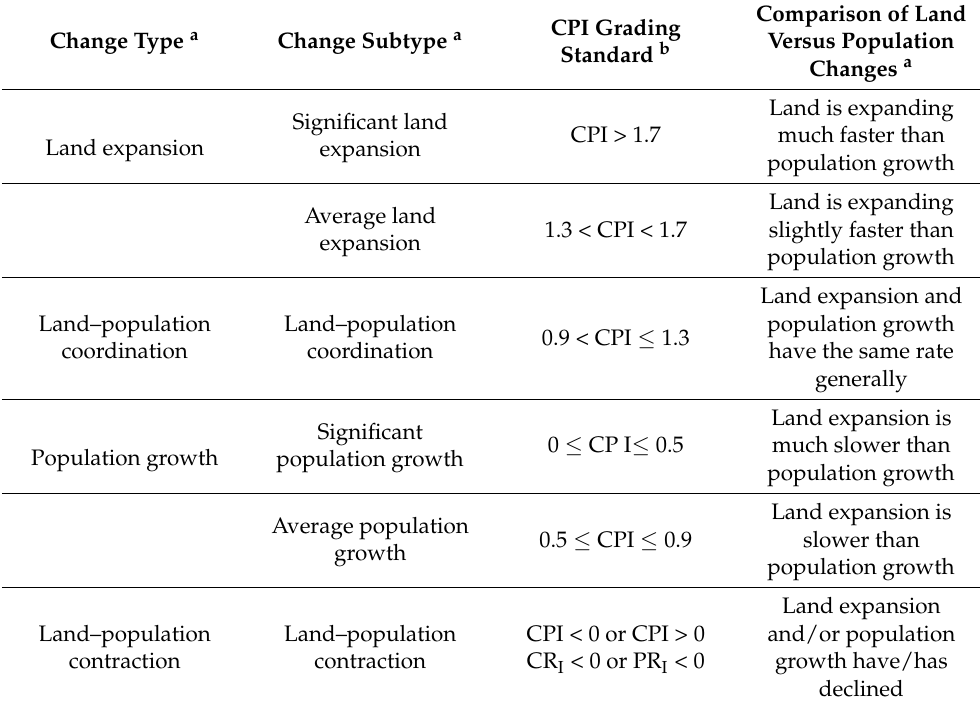
Table 2. Grading standards of the coordination between construction land expansion and population growth are based on the calculated coefficient of coordination (CPI) values.